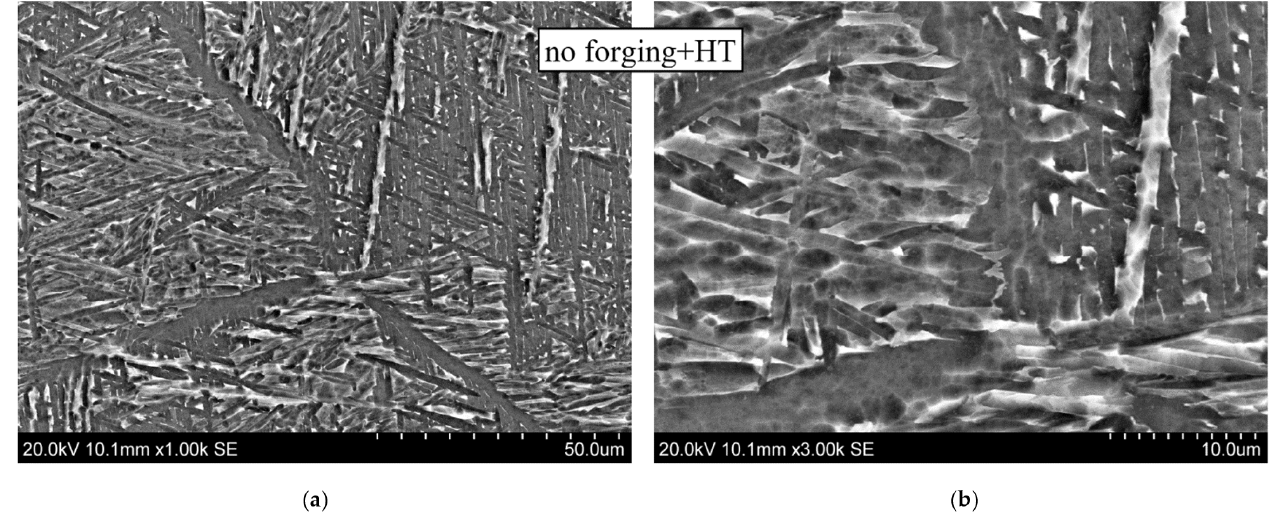
Figure 15. Microstructure of CMT deposition after two-stage annealing: ( a ) ×1000; ( b ) ×3000.